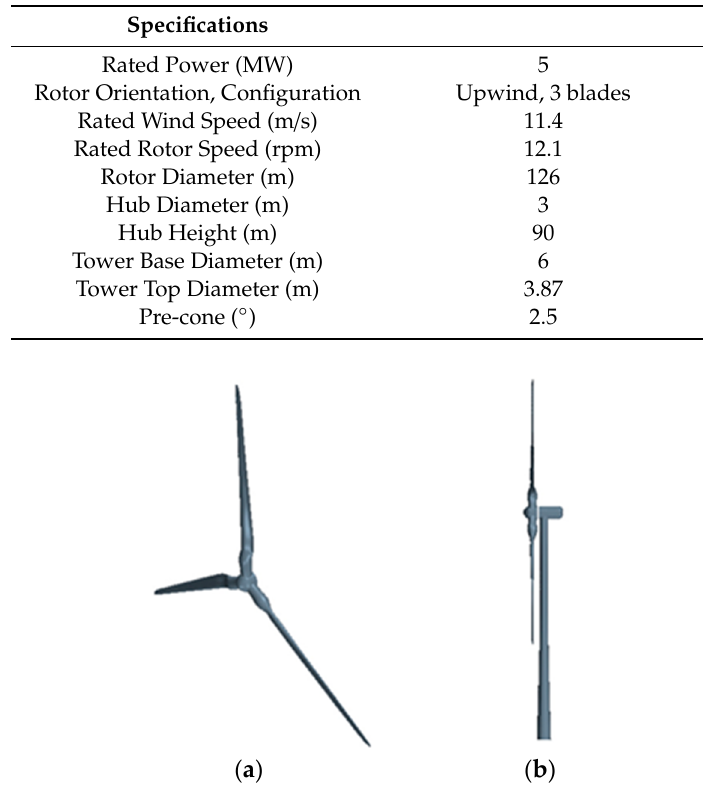
Figure 5. Geometric model of a 5 MW reference wind turbine: ( a ) the rotor geometric model; ( b ) the full configuration model.